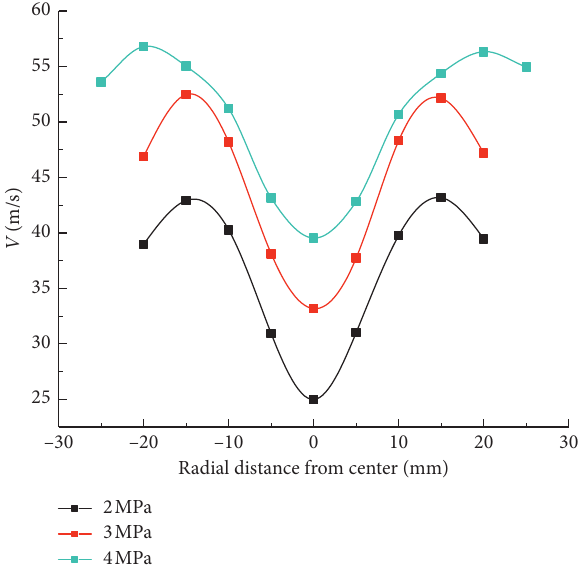
Figure 15: Radial velocity curve of Section